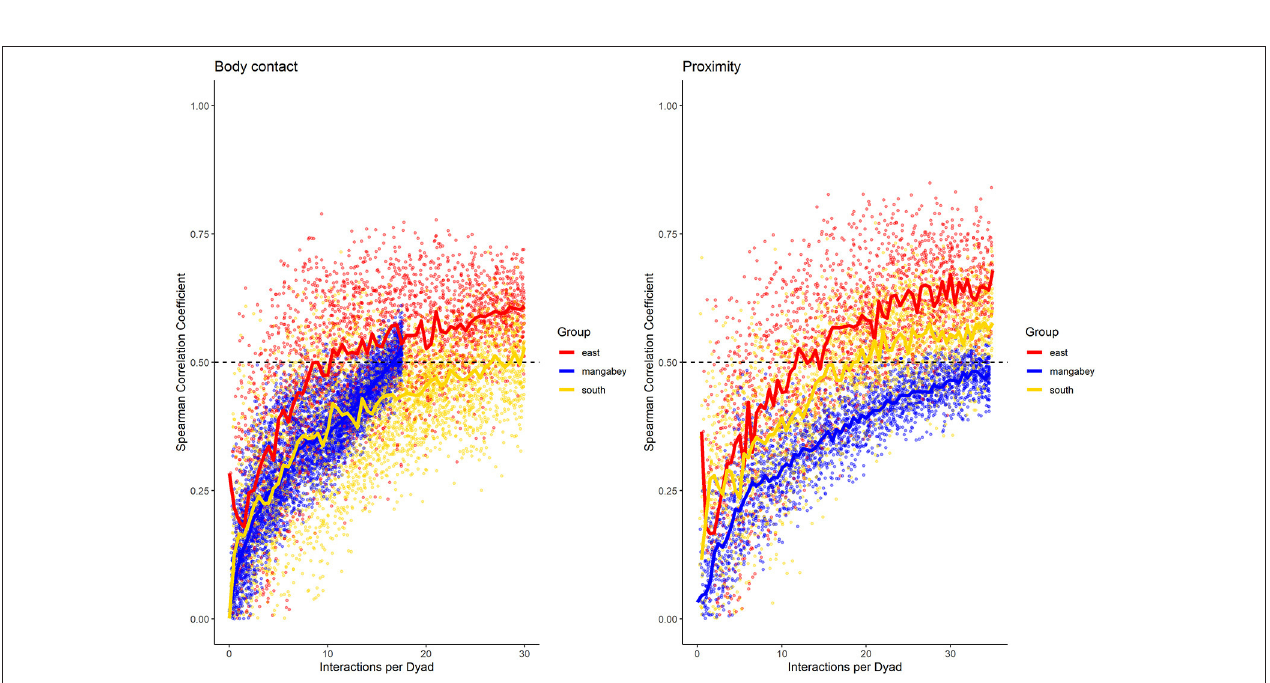
FIGURE 7 | Spearman correlation between two halves of randomly selected subsets of the datasets for mangabeys (blue), East chimpanzee community (red) and South chimpanzee community (golden) for body contact and proximity. The standardized consistency is marked by the number of interactions per dyad where the median of correlation coefficients exceeds r s = 0.5. If that value is reached with fewer interactions per dyad, the distribution of interaction rates is more consistent. Distributions of correlation coefficients with a large spread indicate changes in interaction preference over time.